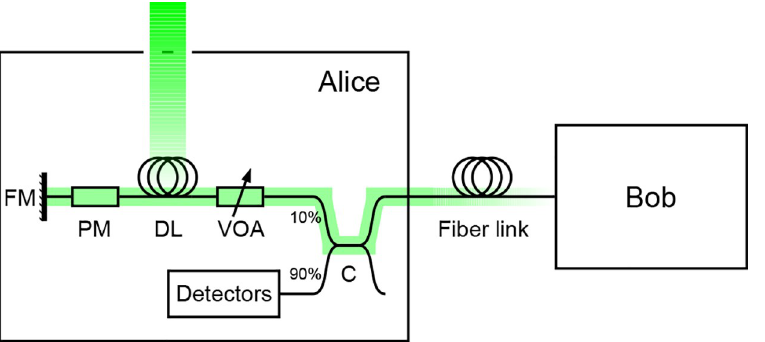
Fig 2. Plug-and-play QKD device under attack. Alice’s side includes a 90:10 optical coupler (C) that diverts part of the light for monitoring to a series of classical detectors, and the quantum part with a variable attenuator (VOA), delay line (DL), phase modulator (PM), and Faraday mirror (FM). Alice uses the PM to introduce a secret phase and makes sure that the total attenuation guarantees that the mean photon number per pulse going back to the fiber channel is less than the value prescribed by the protocol. The coupling path in our attack is shown in green (gray): a ventilation hole in Alice’s case gives light an access to the fiber spool of the DL. From there, the injected photons can get to the phase modulator and carry unwanted information to the outside fiber